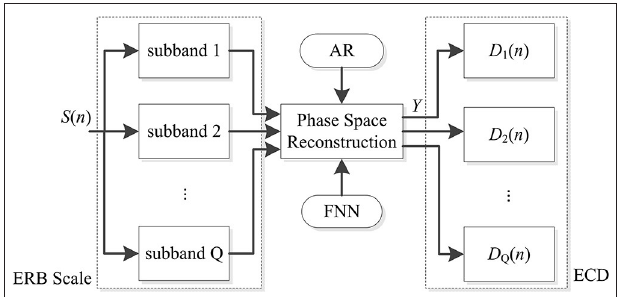
FIGURE 1 | Flow chart of the ECD